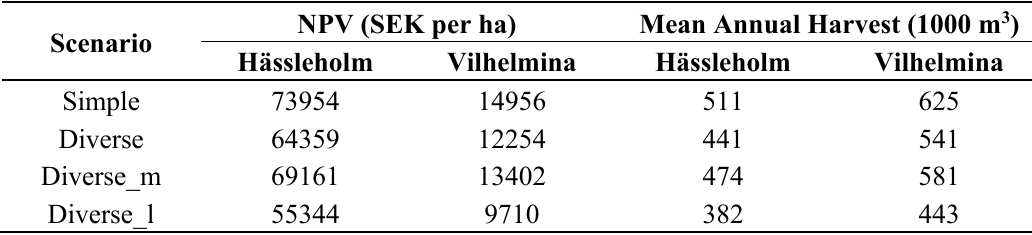
Figure 3. Development of total harvest volume (1000 m 3 /year) in Hässleholm ( left ) and Vilhelmina ( right ) for the Simple and Diverse scenarios, as well as the more intensive (Diverse_m) and less intensive (Diverse_l) variations of the Diverse scenario. Table 9. Net present value (NPV) and mean annual harvest in Hässleholm and